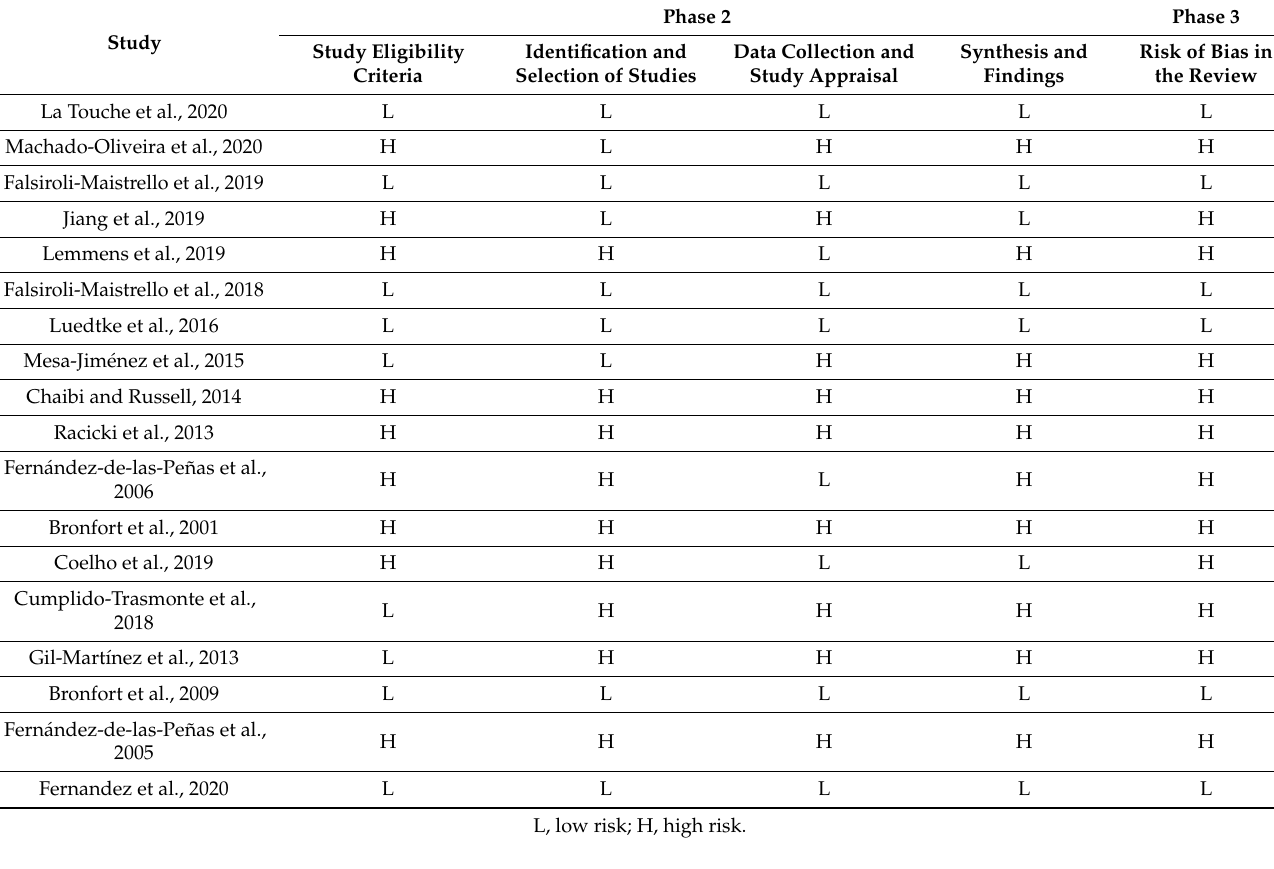
Table 4. Risk of bias assessment in systematic reviews through the ROBIS scale.